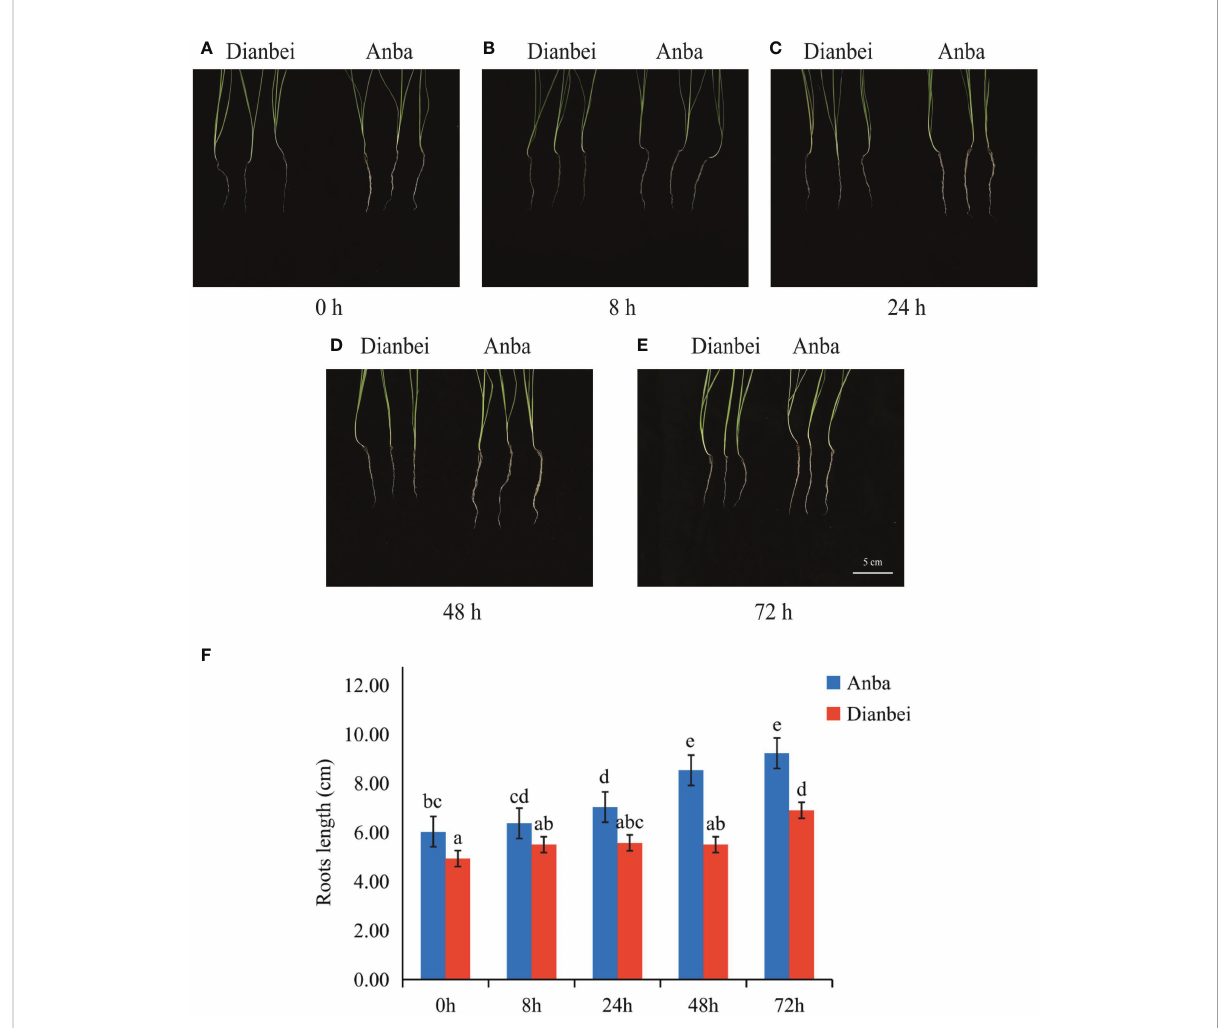
FIGURE 1 Root phenotype and length in Dianbei and Anba. (A-E) The phenotype of Dianbei and Aaba at 0 h (A) , 8 h (B) , 24 h (C) , 48 h (D) , and 72 h (E) . (F) Effects of submergence on the root lengths of Dianbei and Anba. Error bars indicate the standard error, n = 3. Different letters indicate the signi fi cant differences. Statistical analysis using one-way analysis of variance (ANOVA) using Duncan ’ s multiple range test ( P <